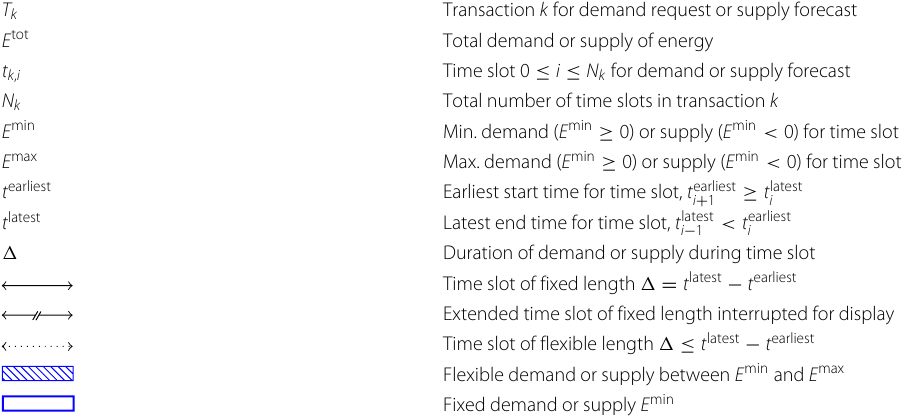
Table 1 Notation and Symbols for